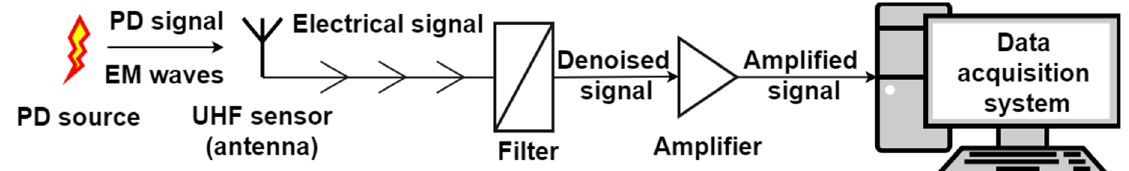
Figure 1. A general process of ultra-high frequency (UHF) measurement.